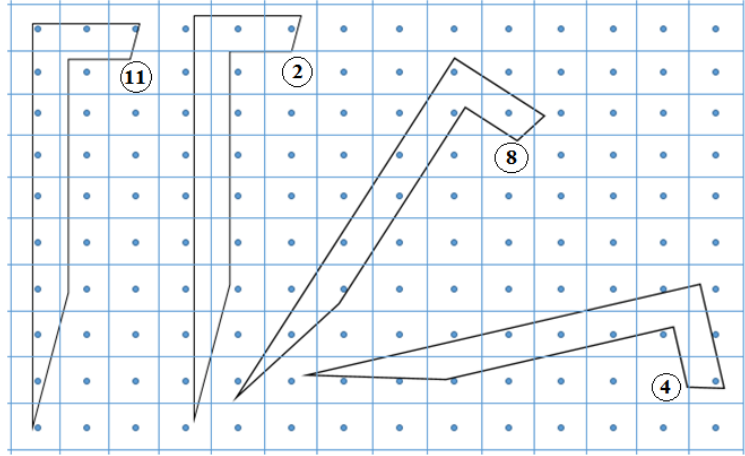
Figure 5. Different numbers of pixels linked to various positions of the parcel on the raster. Number of pixels from left to right: 11, 2, 8, 4. Adapted from [21].